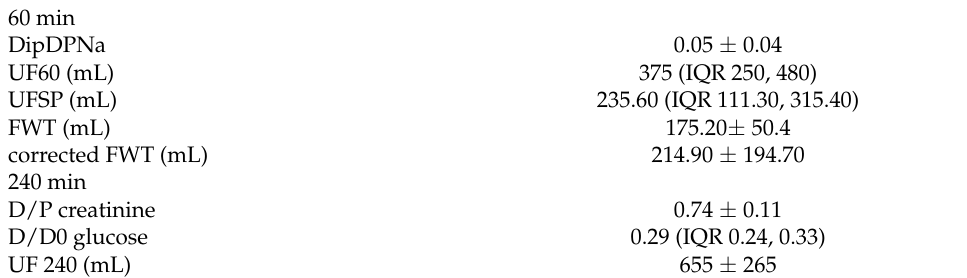
Table 2. Baseline peritoneal transport